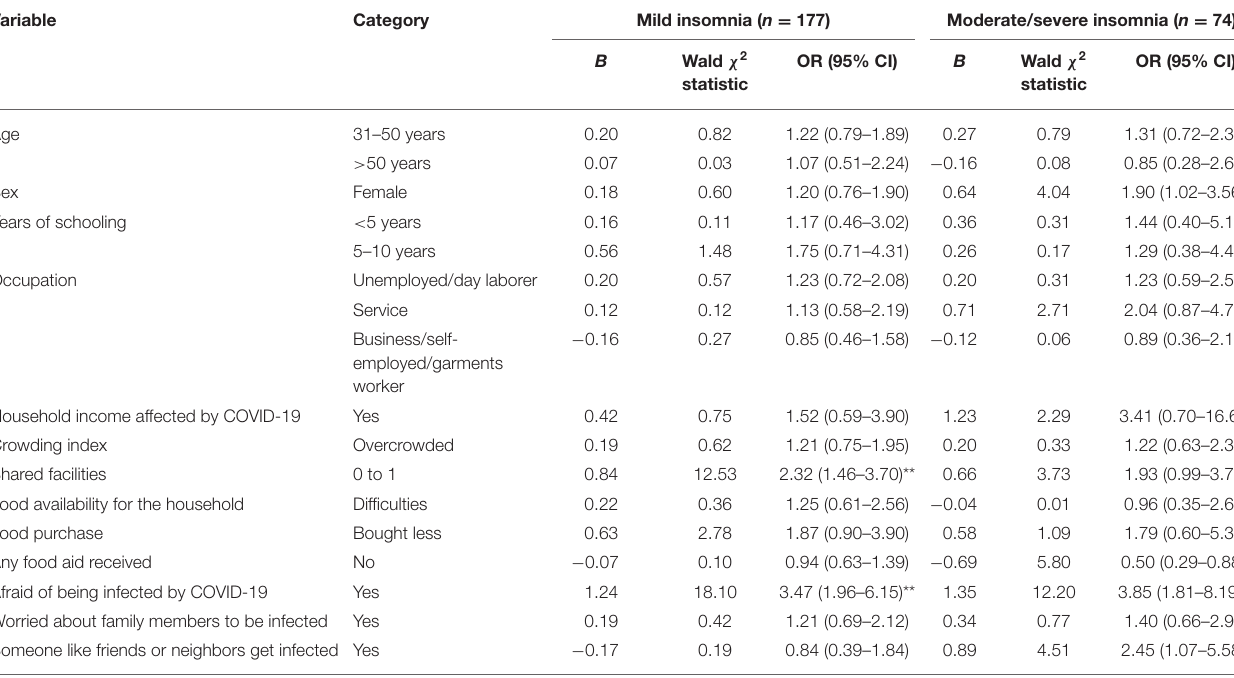
TABLE 5 | Multinomial logistic regression differentiating minimal insomnia ( n = 335) from mild and moderate/severe insomnia.